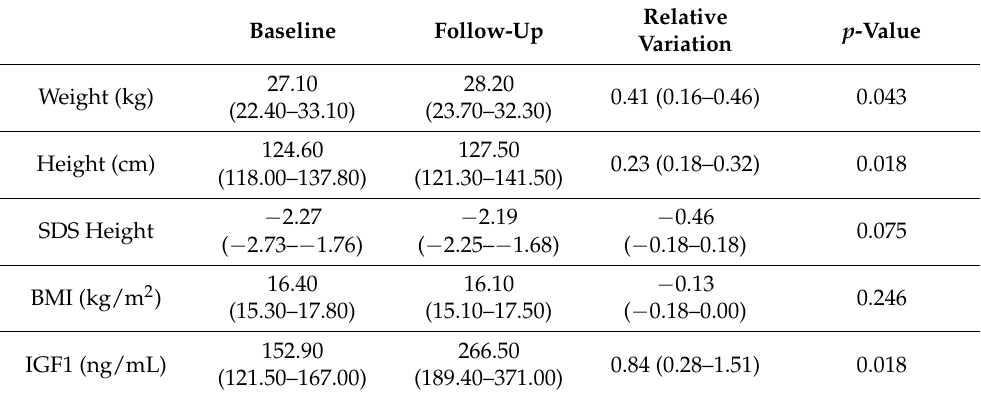
Table 1. Median and interquartile range (IQR) of axiological characteristics of the 7 GH-treated patients.